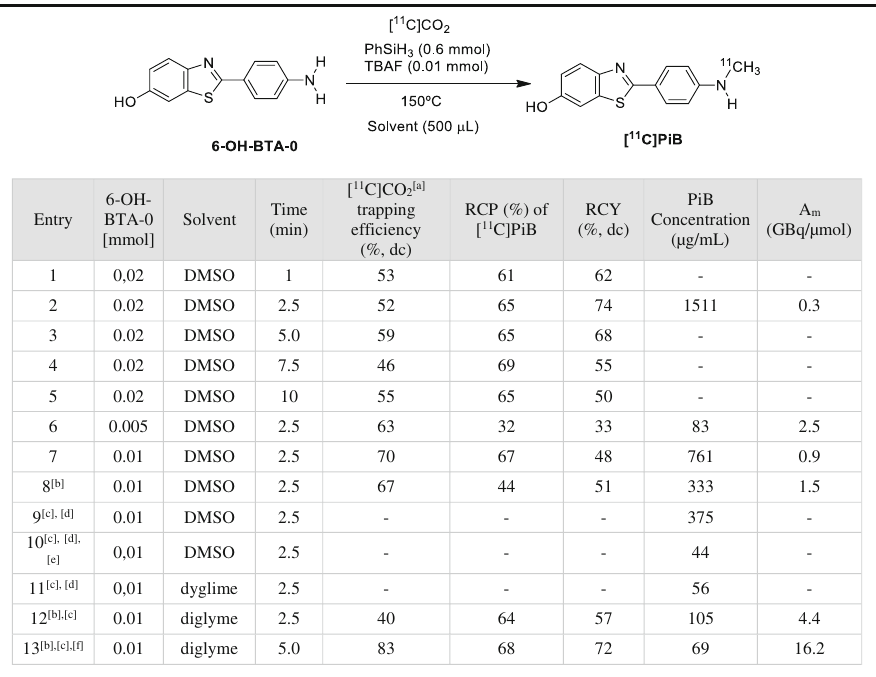
Table 2 Optimisation of reaction conditions for radiolabelling [ 11 C] PIB from direct [ 11 C]CO 2